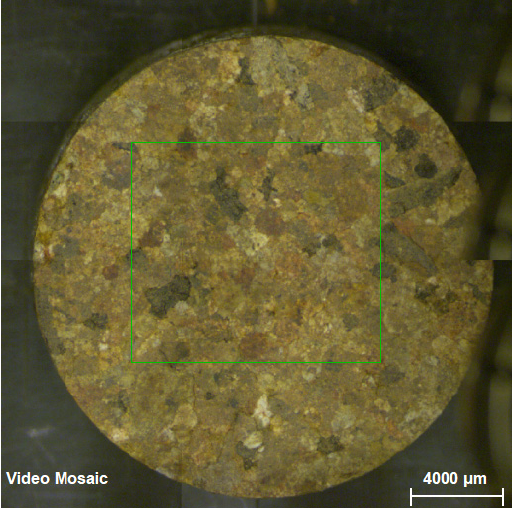
Figure 2. Pellet of an original SD1 sample of grain size fraction “<2 mm to ≥ 500 µm” (image source: Bruker’s M4 TORNADO camera).